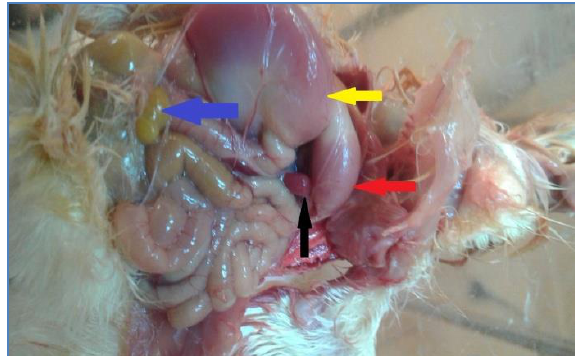
(Figure, 1): Photography of spleen at 1 day after hatching showing spleen (black arrow), proventriculus (red arrow), gizzard (yellow arrow) and yolk sac (blue arrow).